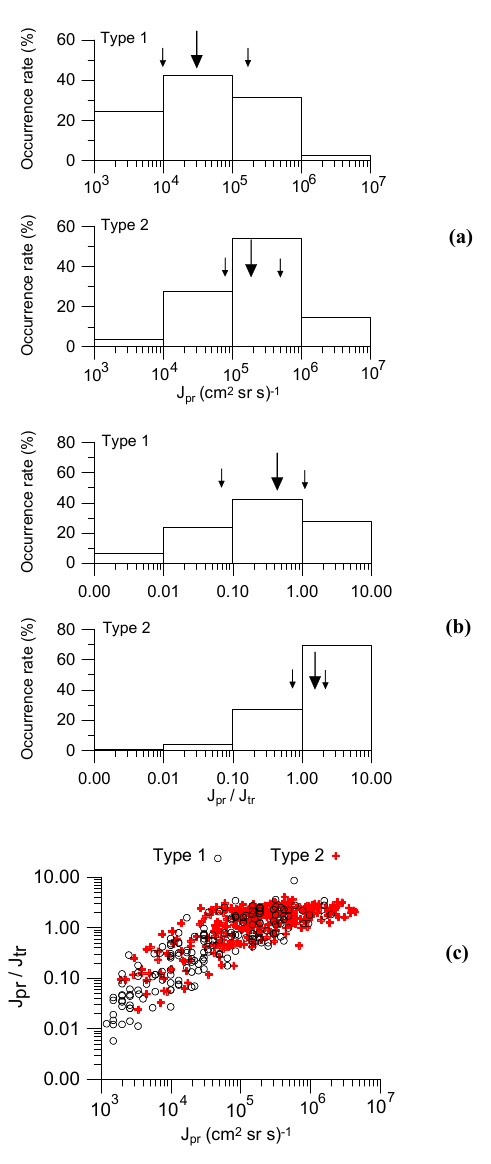
Figure 3 Fig. 3. Features of the localized proton precipitation. (a) Normal- ized distribution of the events as a function of the precipitating par- ticle flux. Median value of the flux (large arrow), as well as first and third quartiles (small arrows) are indicated. (b) Normalized distri- bution of the events as a function of the J prec /J trap ratio. Me- dian value of the izotropization parameter, as well as first and third quartiles are shown as above. (c) Dependence of isotropization pa- rameter ( J prec /J trap ) on the precipitating flux for events of Type 1 (circles) and Type 2